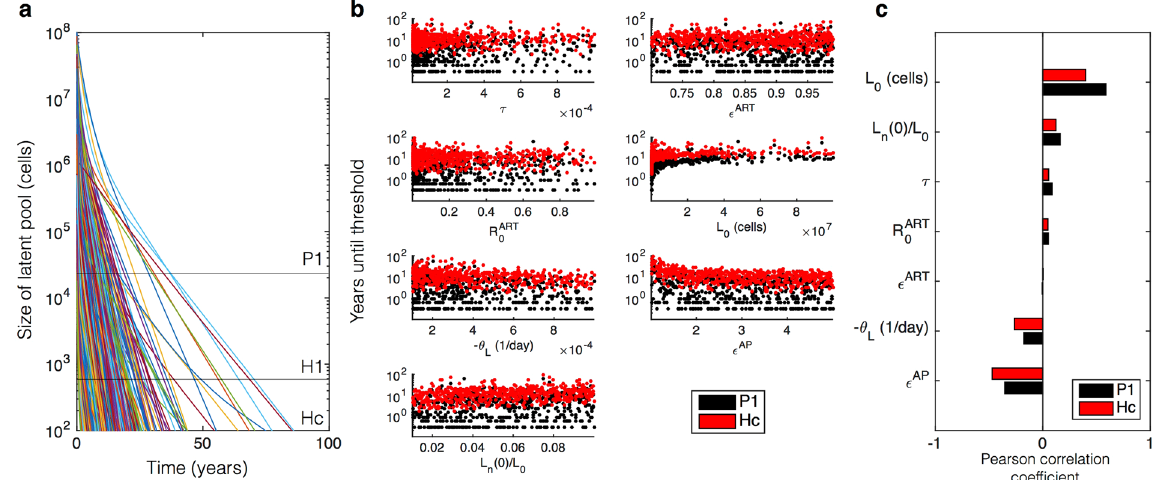
Figure 4. Global sensitivity analysis. We use the ranges of parameters from Supplementary Table S4. ( a ) 1,000 simulations drawn from Latin Hypercube sample parameter sets where < R 1 ART are shown to demonstrate the 0 variability of latent pool dynamics with respect to all combinations of parameter ranges. ( b ) The time until each cure threshold, Pinkevych 1-yr (P1) and Hill cure (Hc), are calculated as the time when the latent reservoir contains fewer than 20,000 and 200 cells respectively. In some cases cures are achieved within months. In others, cure requires many years. ( c ) Pearson correlation coefficients indicate the correlations between each variable and time to cure. L 0 is the initial number of latent cells. L n (0)/ L 0 is the initial fraction of naïve cells in the latent pool. τ is the probability of latency given infection. R ART is the basic reproductive number on ART. ε ART is 0